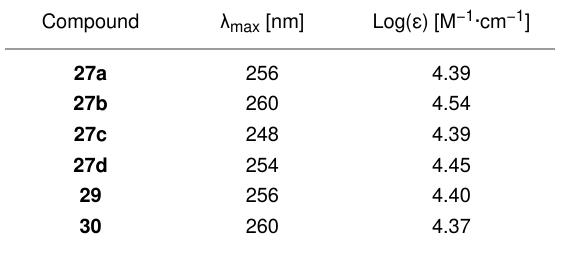
Table 2: Absorption maxima ( λ max ) and molar extinction coefficient ε at the absorption maximum [44].